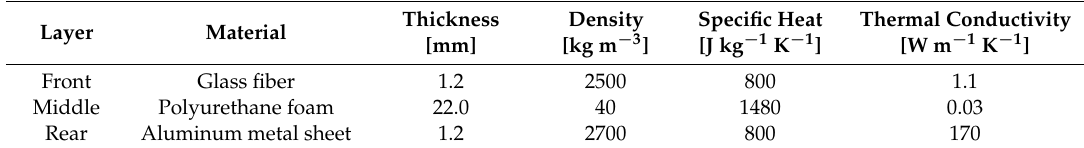
Figure 2. Thermal model of the panel. The z axis is not represented in the image.